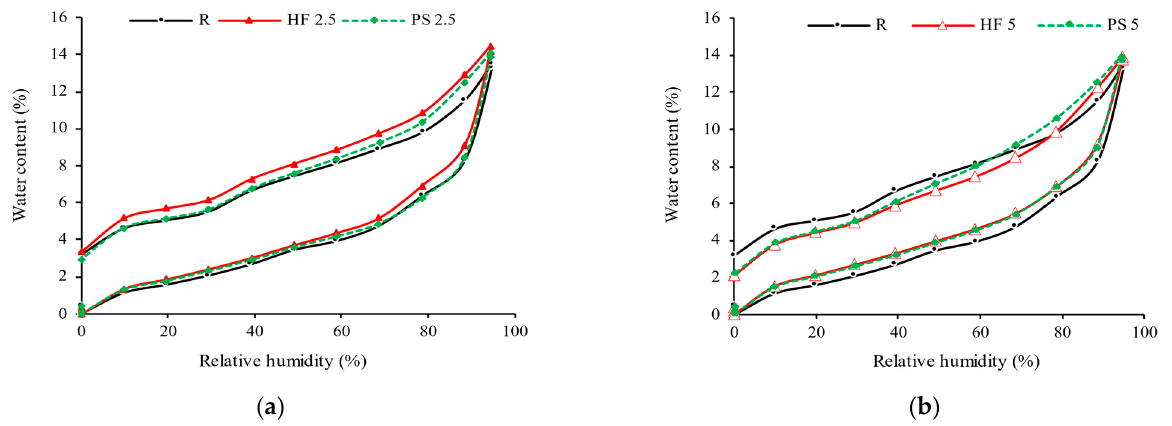
Figure 9. Sorption isotherms of fiber mortar with different contents of fibers, including ( a ) 2.5%; ( b ) 5%.